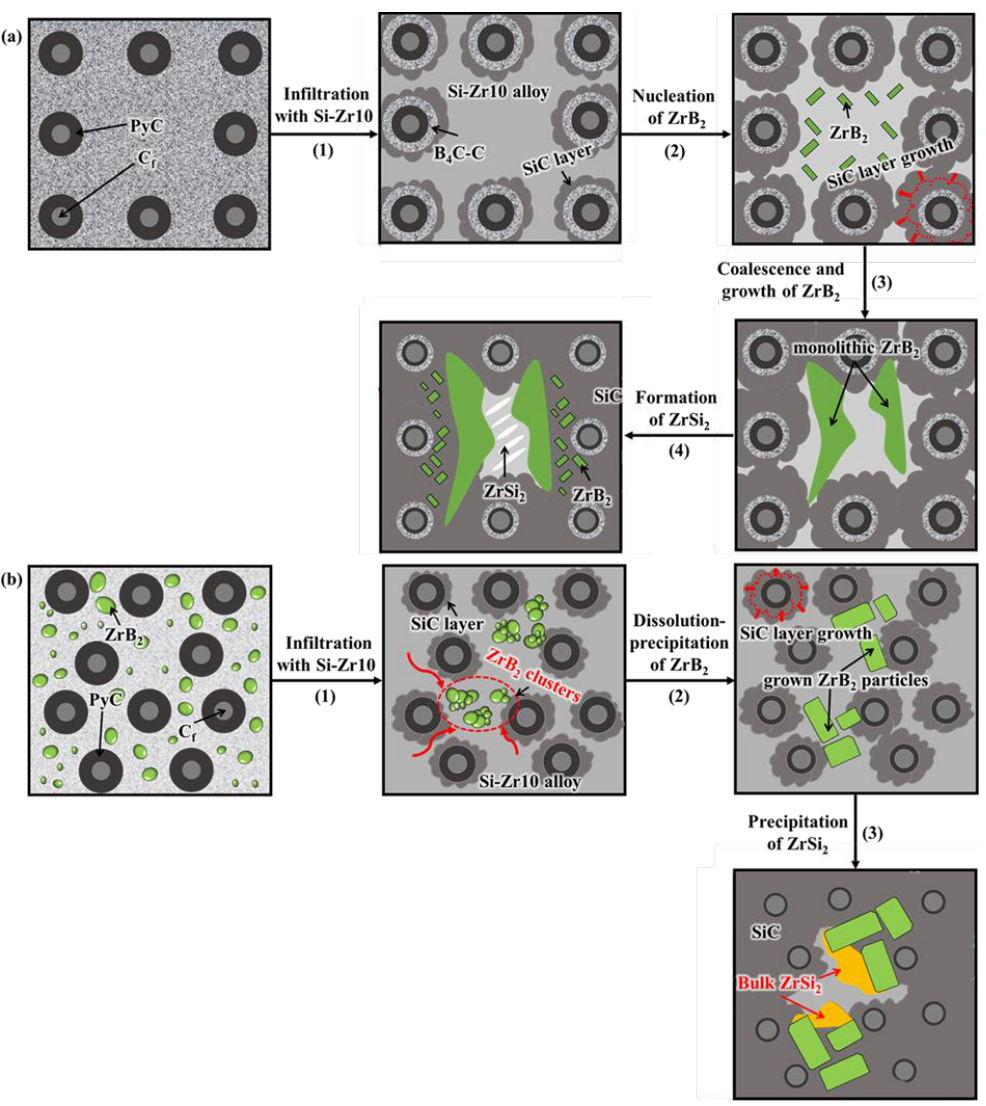
Figure 7. Schematic illustrations of microstructural evolution and formation mechanism for C/C–SiC–ZrB 2 composites during the RMI process: ( a ) B 4 C-composite; ( b ) ZrB 2